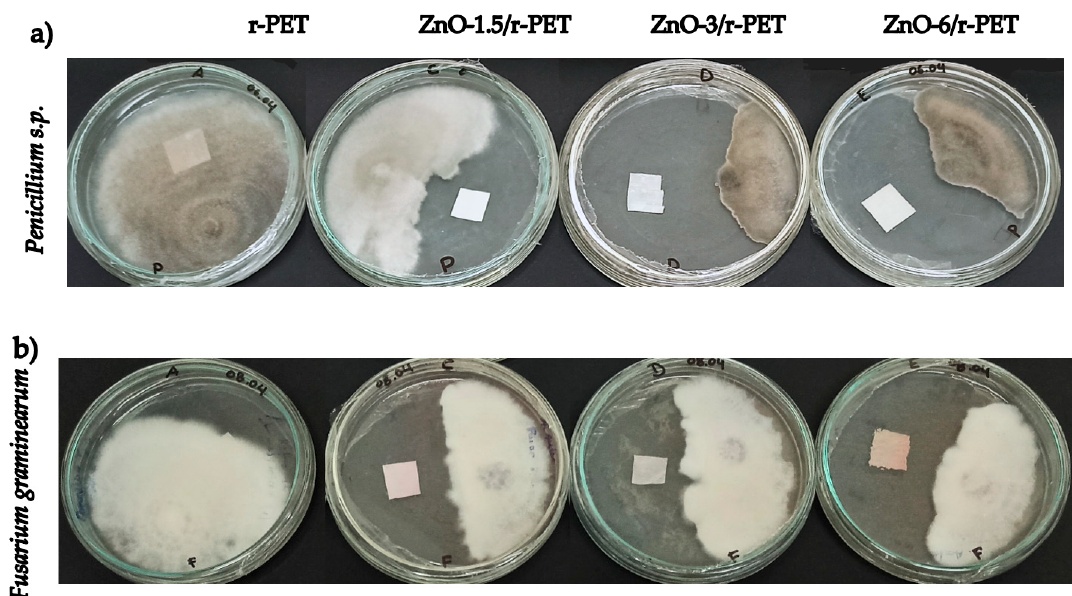
Figure 6. The growth of ( a ) Penicillium s.p and ( b ) Fusarium graminearum in r-PET composite fibers.